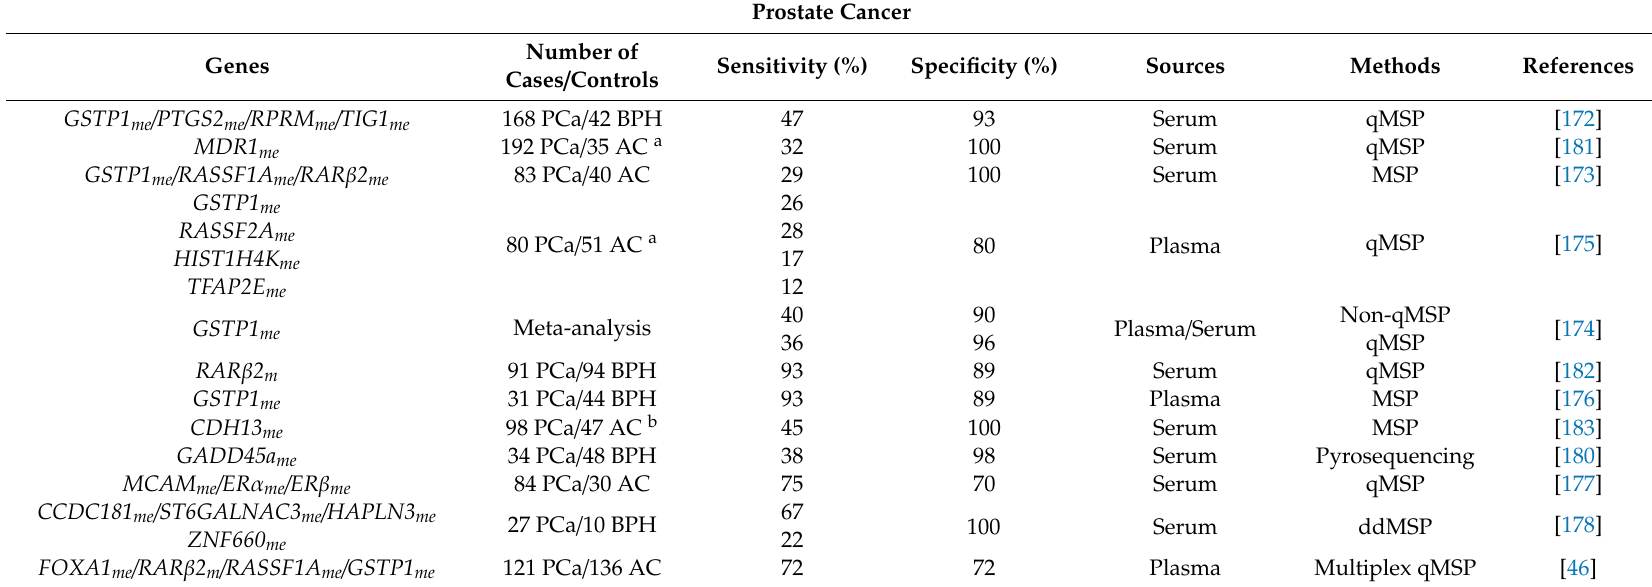
Table 4. CcfDNA-based methylation biomarkers for prostate cancer (PCa)